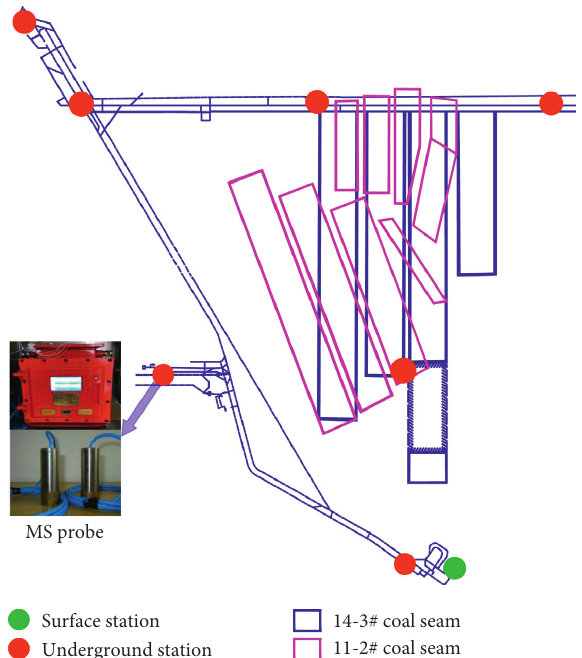
Figure 8: Schematic diagram of Microseismic equipment and probe layout. Table 1: Stratified statistical table of microseismic